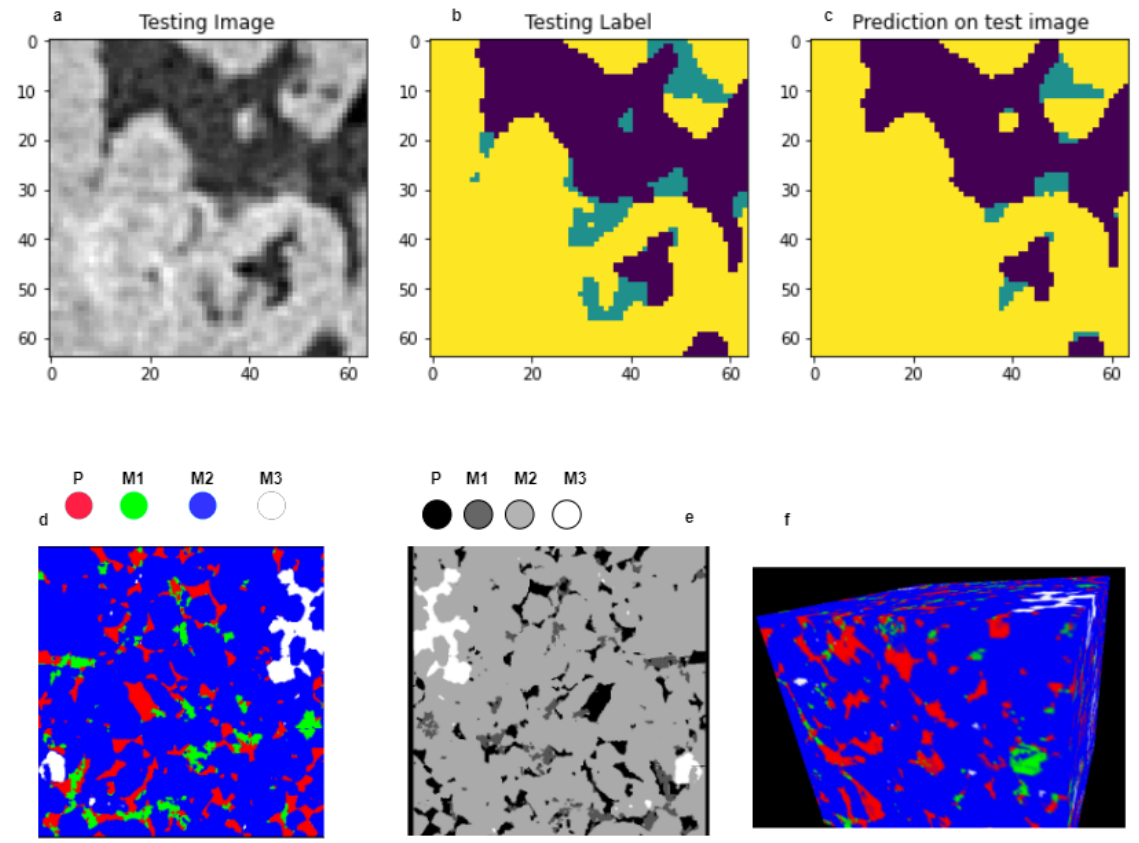
Figure 3. Represents prediction, segmented sample both in 2D and 3D. ( a ) Test image of individual slice. ( b ) Test mask of individual slice. ( c ) Prediction on test image. ( d ) Two-dimensional (2D) representation of segmented result in RGB where the red area represents pores, lime is mineral 1, blue is mineral 2, and finally, white represents mineral 3. ( e ) Representation of segmented 2D result in grayscale. ( f ) Representation of 3D volume segmented